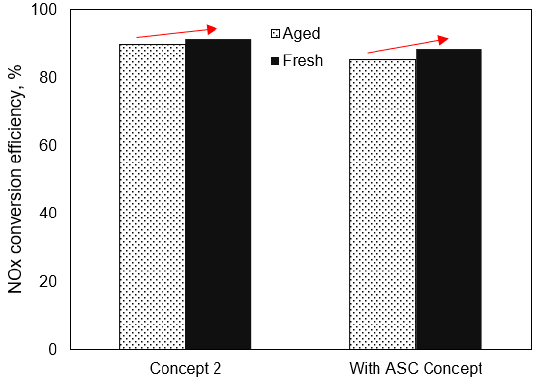
Figure 10. NOx conversion efficiency results during NRTC with aged catalysts vs. fresh catalysts.